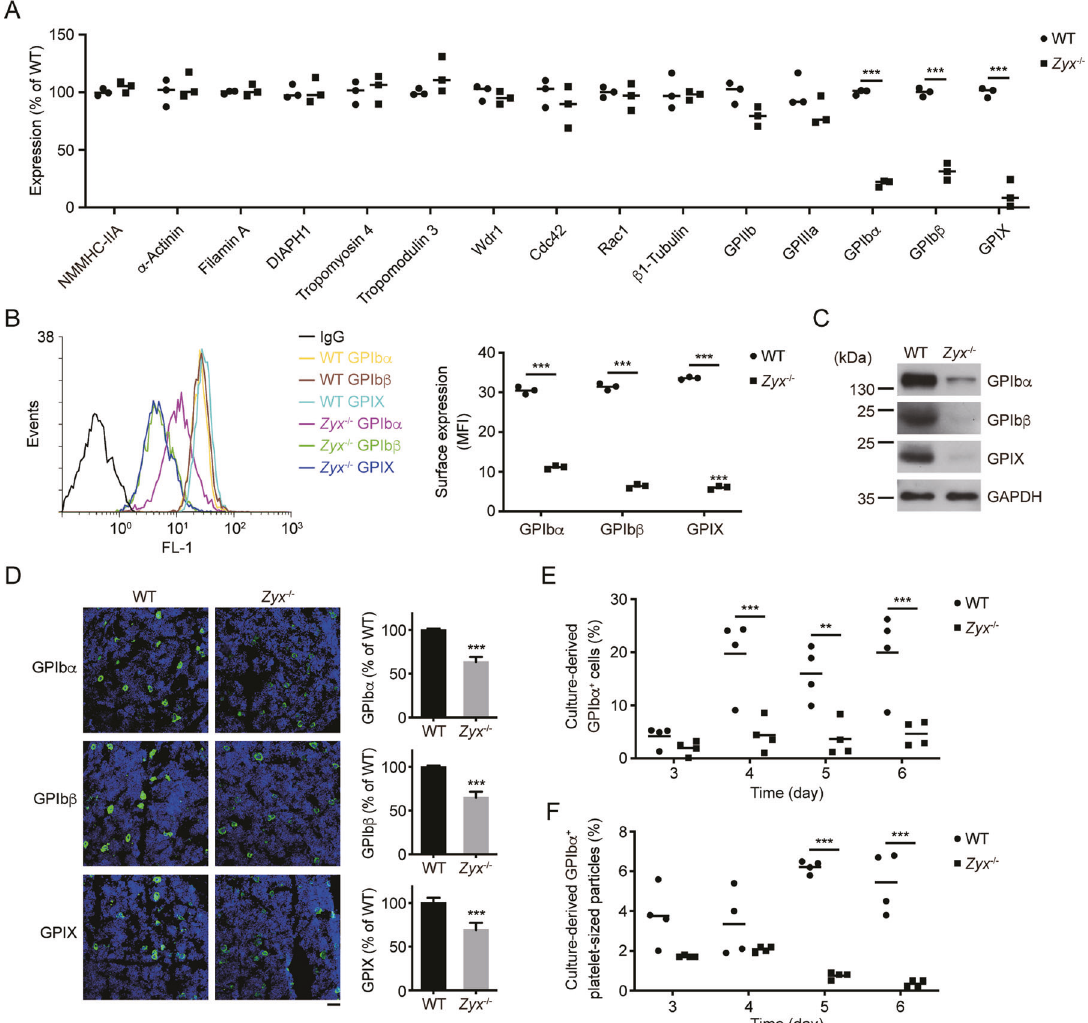
genotype. MFI, mean fl uorescence intensity. C Western blot analysis of GPIb-IX in WT and Zyx − / − platelets. Protein concentration has been adjusted to the same level between WT and Zyx − / − platelet lysates. Blots are representative of fi ve independent experiments. D Expression of GPIb-IX complex in WT and Zyx − / − MKs. Left panels, representative confocal images of MKs in WT and Zyx − / − mouse femoral BM sections immunostained with anti-GPIb α , GPIb β , and GPIX antibodies (original magni fi cation ×200). GPIb α , GPIb β , and GPIX in MKs are in green, and nuclei are in blue. Scale bar: 100 μ m. Right panels, the quanti fi cation of MFI of GPIb α , GPIb β , and GPIX in the left panels analyzed by ImageJ software; n = 10 visual fi elds from 5 mice per genotype. Data are expressed as means ± SD. E Percentage of GPIb α + cells differentiated from WT and Zyx − / − FL HPCs was analyzed by fl ow cytometry. F Percentage of GPIb α + platelet-sized particles released from culture-derived MKs in ( E ) was analyzed by fl ow cytometry. Data are from four independent experiments in ( E ) and ( F ). Means are indicated by horizontal lines in ( A ), ( B ), ( E ), and ( F ). ** P < 0.01, *** P < 0.001, compared with WT mice by unpaired Student ’ s t -test in ( A ), ( B ), and ( D ), and by two-way ANOVA followed by Bonferroni ’ s post hoc test in ( E ) and ( F